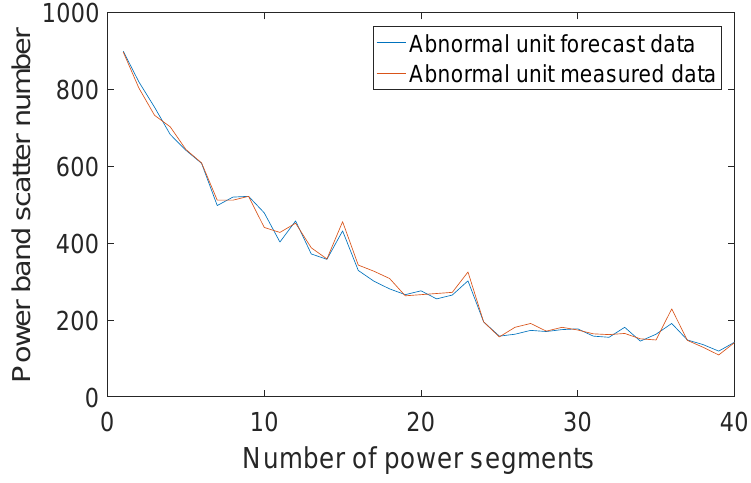
Figure 7. Comparison of convolutional neural network model prediction data and measured